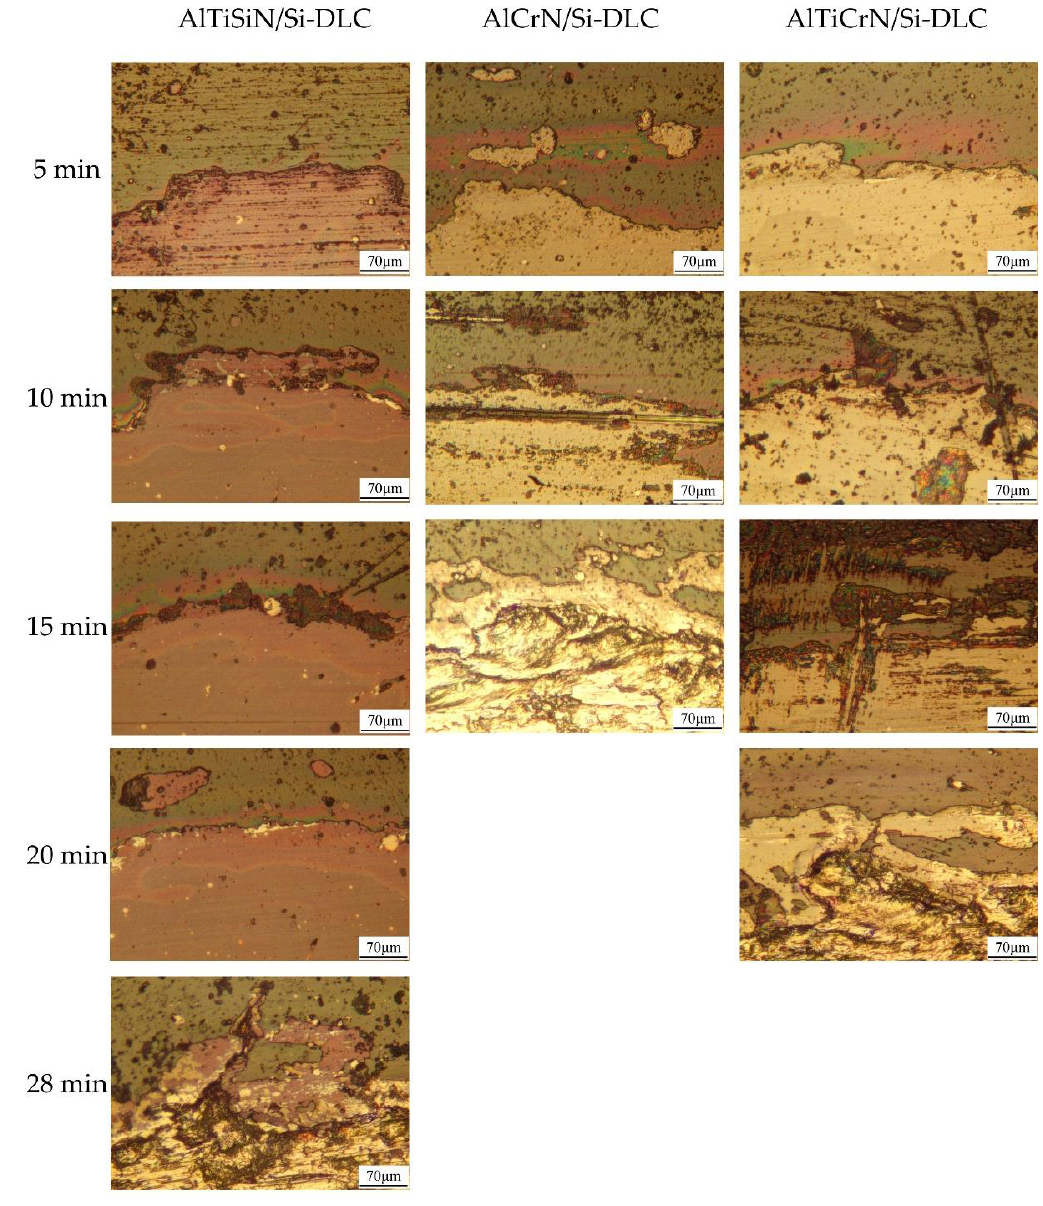
Figure 10. Wear edge morphology of Si-DLC coatings with different transition layers.